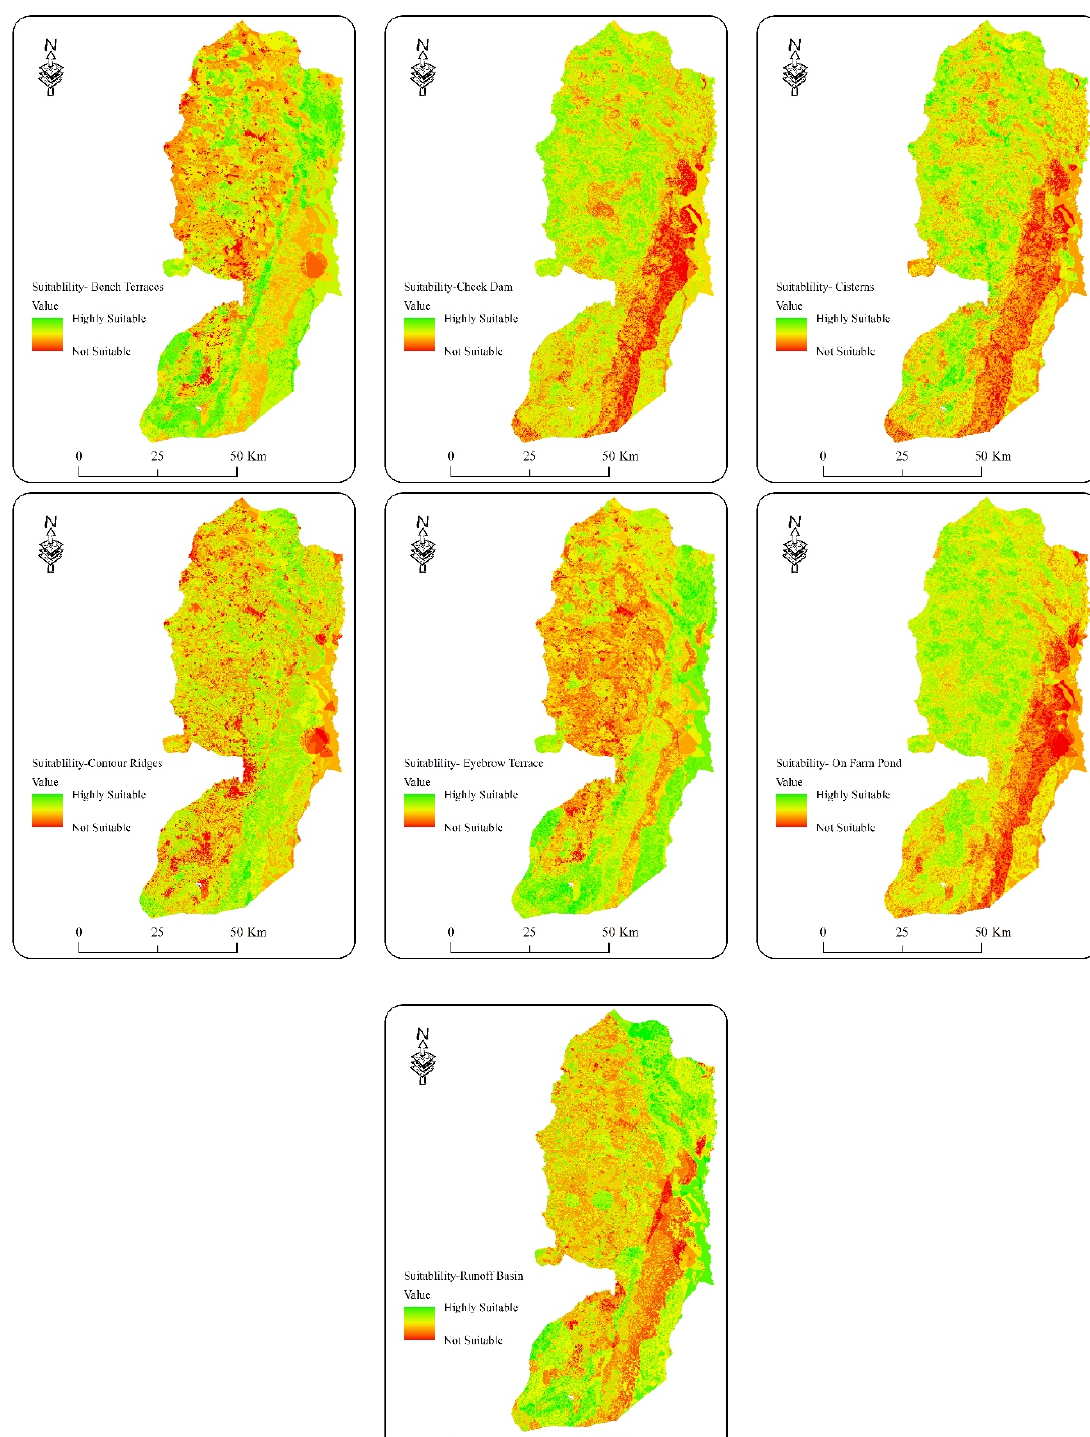
Figure 4. Suitability maps for different types of RWHt in the WB, Palestine, based on soil type, slope, rainfall, land use, and curved number.